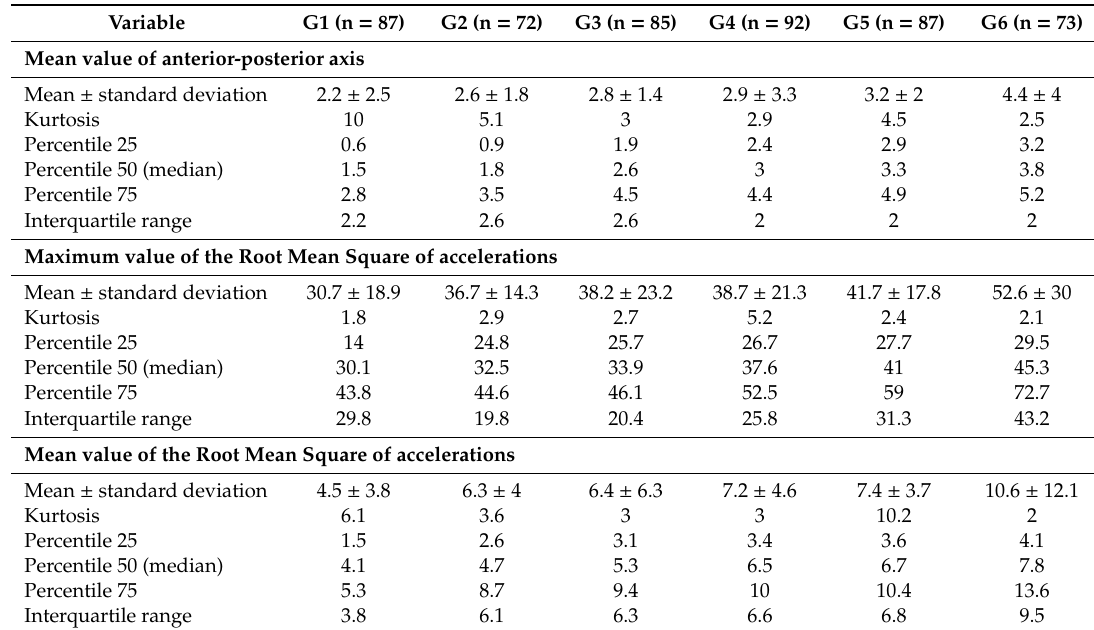
Table 3. Percentiles and descriptive statistics for the monopodal balance test with closed eyes by age group.